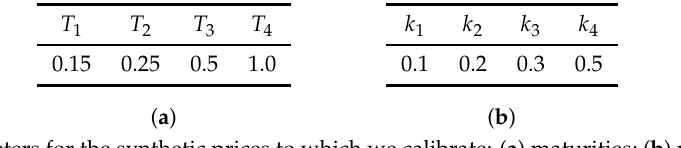
Figure 2. Parameters for the synthetic prices to which we calibrate: ( a ) maturities; ( b ) parameters that define the strikes for the call options per